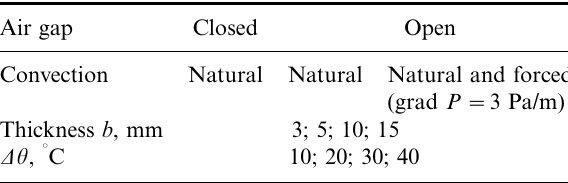
Table 1. Data for modelling the influence of convection